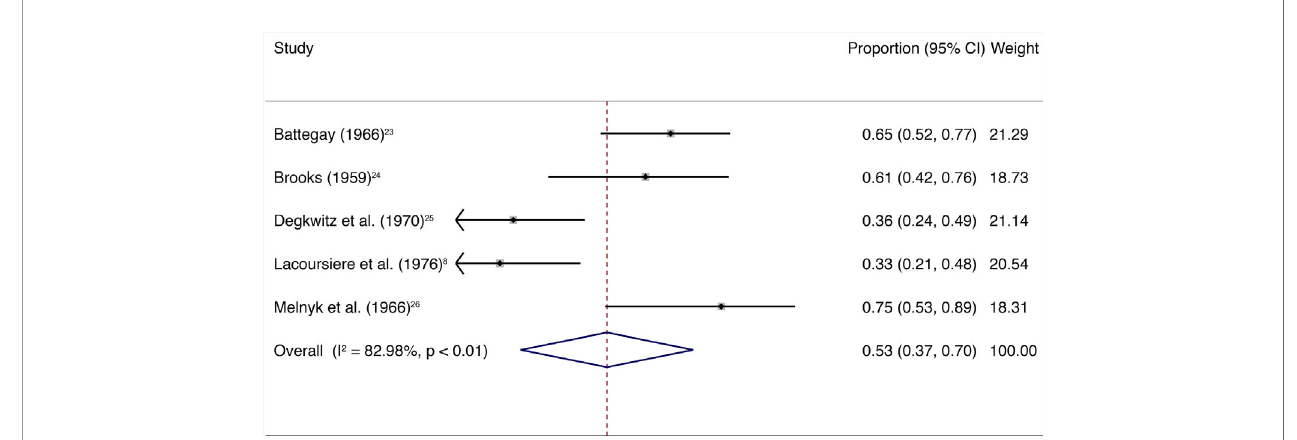
FIGURE 1 | The square data markers indicate the proportion of individuals with withdrawal symptoms in each study, with sizes re fl ecting the study ’ s statistical weight using random-effects meta-analysis of proportions. The horizontal lines indicate 95% CIs. The blue diamond data marker represents the overall proportion and 95% CI. The vertical dashed line shows the summary effect estimate.